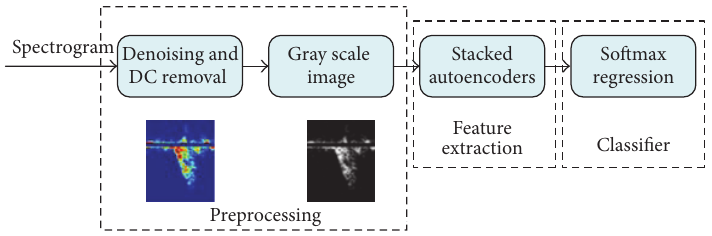
Figure 15: Block diagram of the deep learning based fall detector